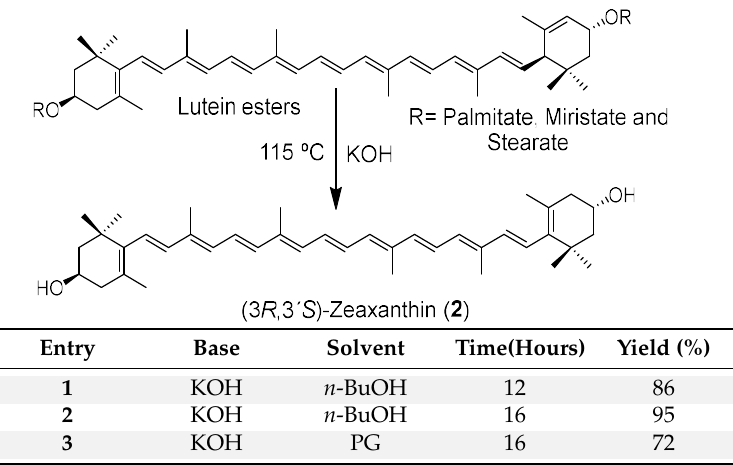
Table 2. One-pot reaction conditions starting from lutein esters to meso-zeaxanthin.